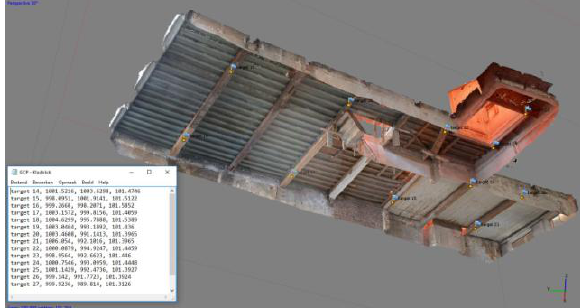
Figure 8. Floor construction dated 1630. Modelled